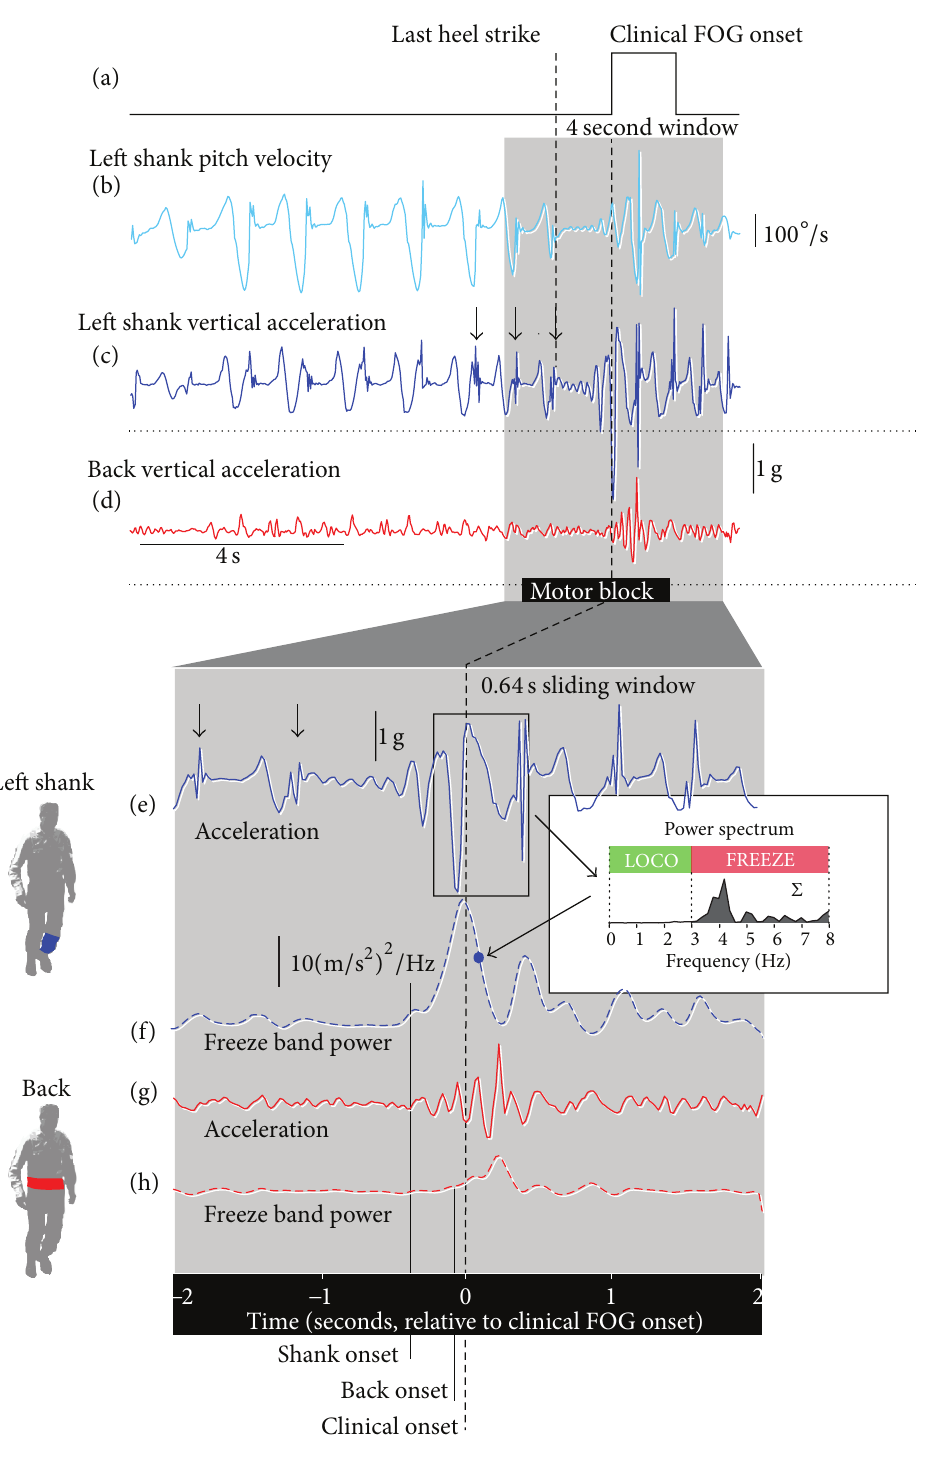
Figure 1: Typical FOG event. (a) Clinicians rating of FOG from video generated a binary trace, with “1” indicating a freeze event. (b) Left shank pitch velocity. (c) Left shank vertical acceleration. (d) Back vertical acceleration. (e) 4 s of shank acceleration, centered on the clinical onset of FOG. (f) Freeze band power of the shank was calculated at each point in time within a 0.64 s window by summation of power in the 3–8 Hz band. (g) 4s of back acceleration, centered on the clinical onset of FOG. (h) Freeze band power of the back was calculated at each point in time within a 0.64 s window by summation of power in the 3–8Hz band. In this instance, the onset of freeze band power ( > 3 SD above baseline) occurred initially in the shank, approximately 300 ms prior to onset at the